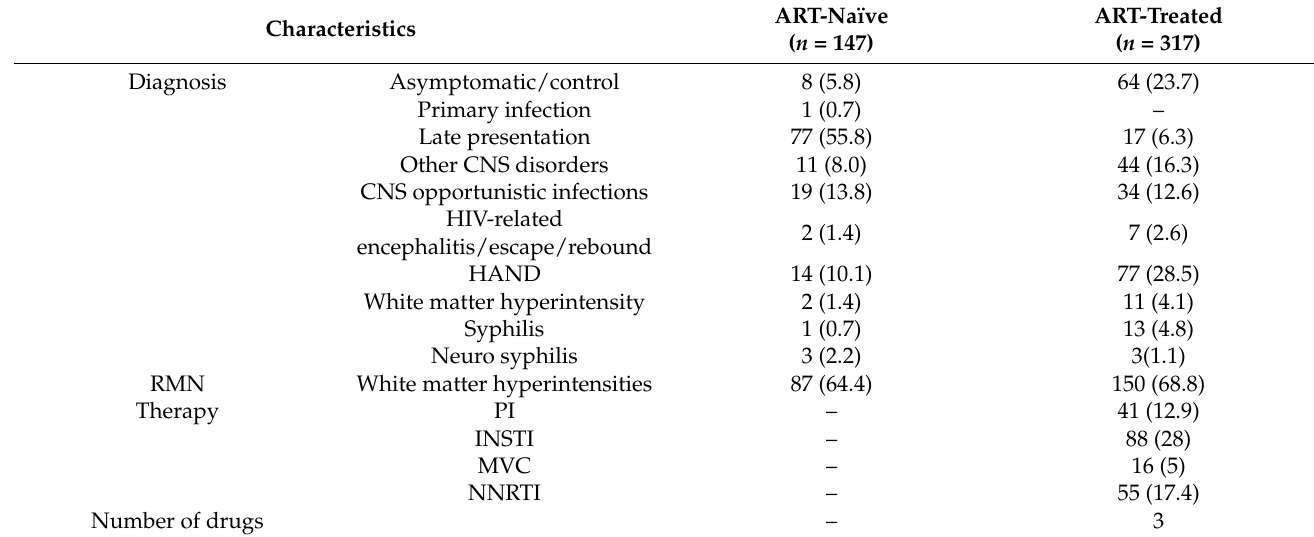
Table 2. Clinical and cART-related features of study participants.